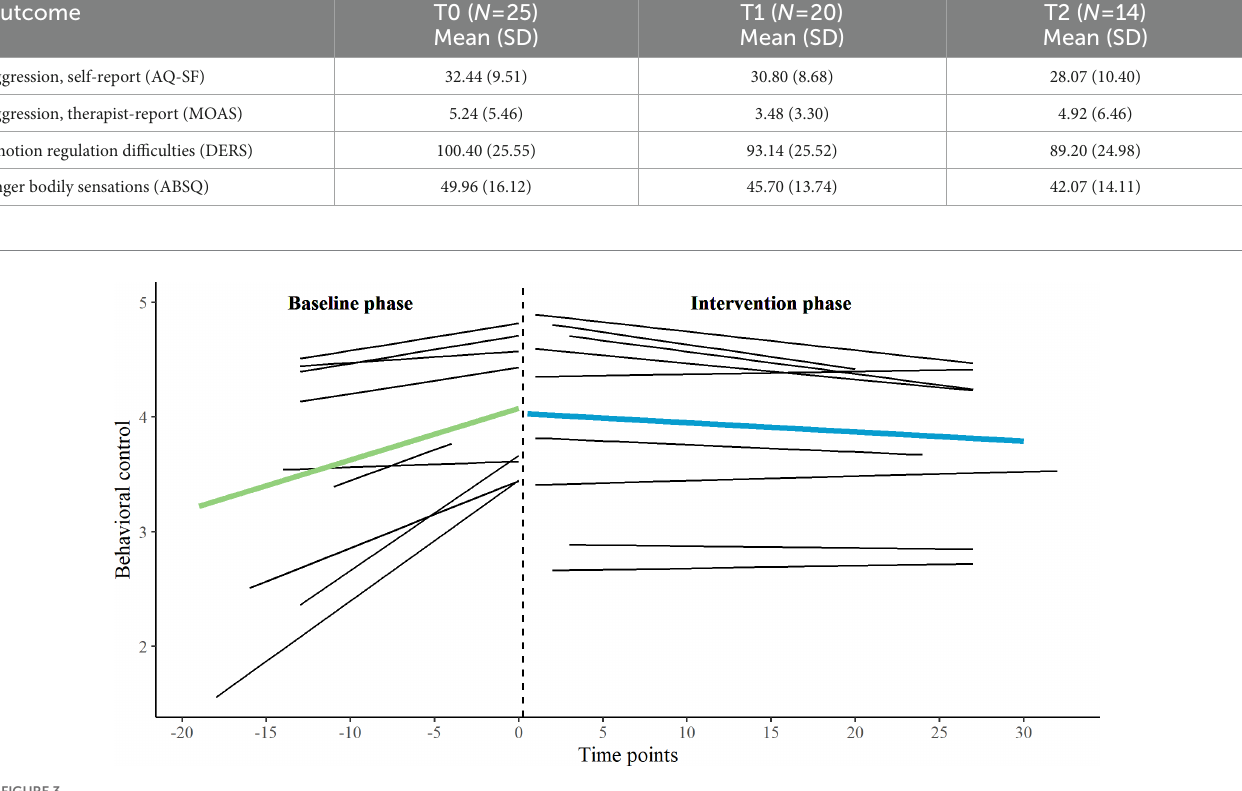
FIGURE 3 Combination of one- and two-level regression results for primary EMA measure behavioral control, measured twice a day on a 5-point Likert scale, in baseline phase A 1 and intervention phase